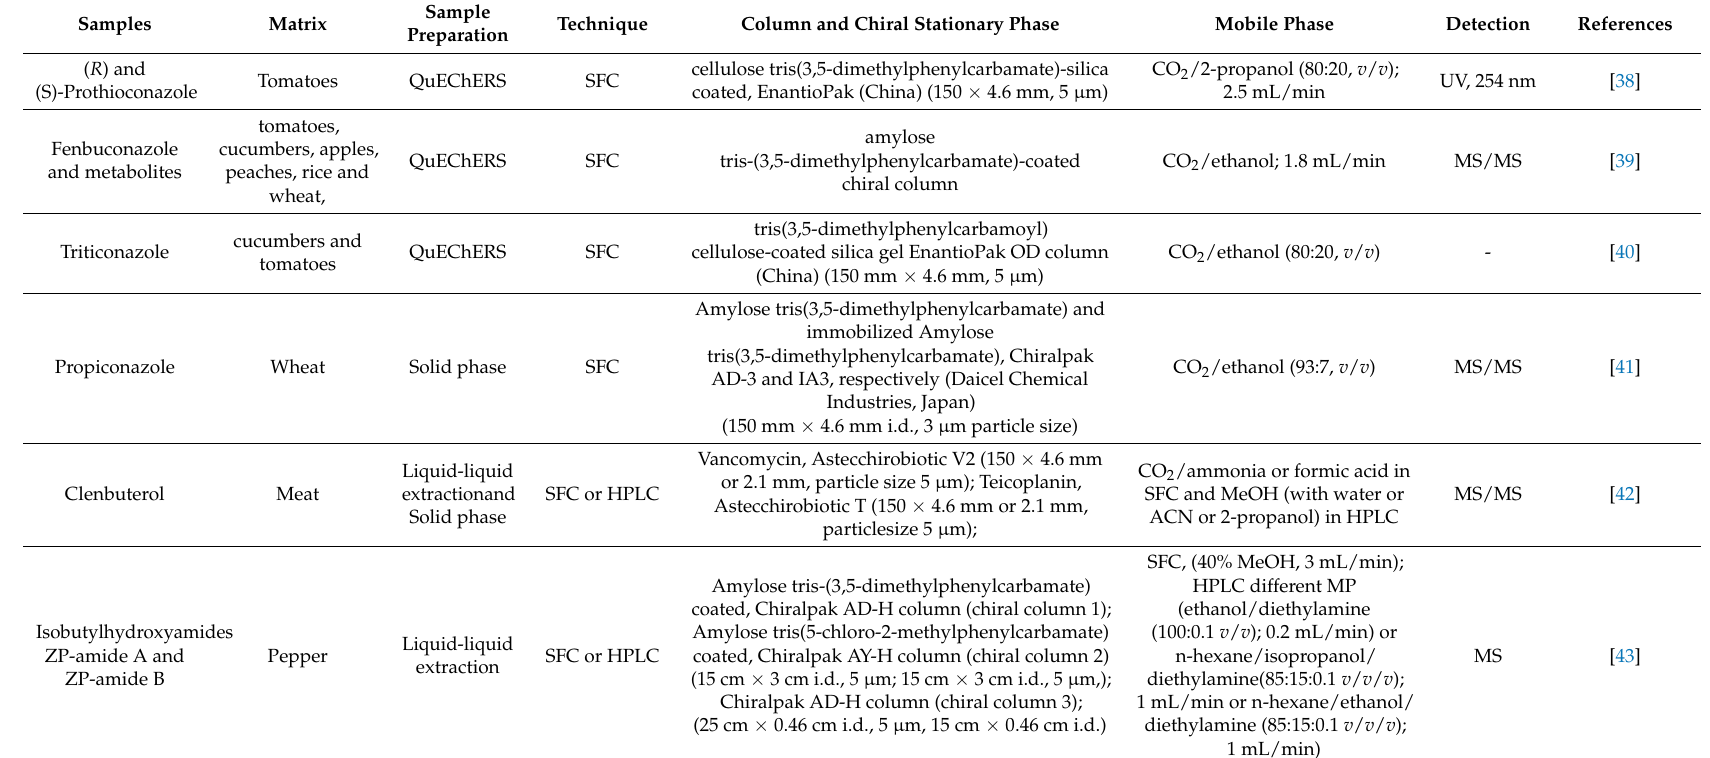
Table 1. Selected applications of supercritical fluid chromatography (SFC) to Food